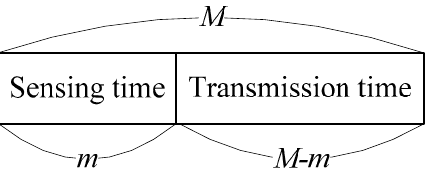
Figure 10. Time distribution diagram of transmission cycle.